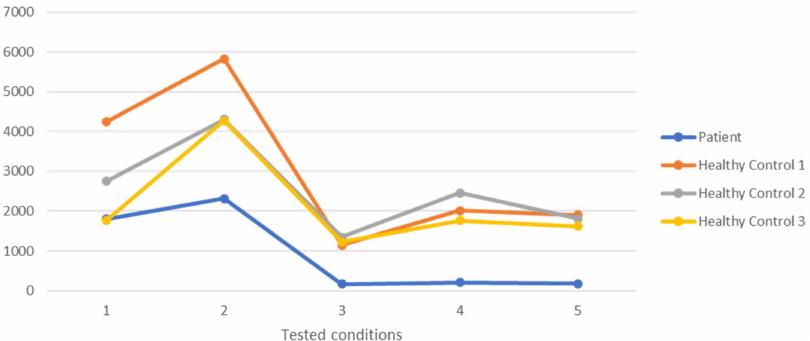
Figure 1. Inosine (ng/mL) produced by a patient and three healthy controls at the following five conditions: EHNA 0 mM and Adenosine 1 mM (1), EHNA 0 mM and Adenosine 2 mM (2), EHNA 1 mM and Adenosine 1 mM (3), EHNA 1 mM and Adenosine 2 mM (4), and EHNA 2 mM and Adenosine 2 mM